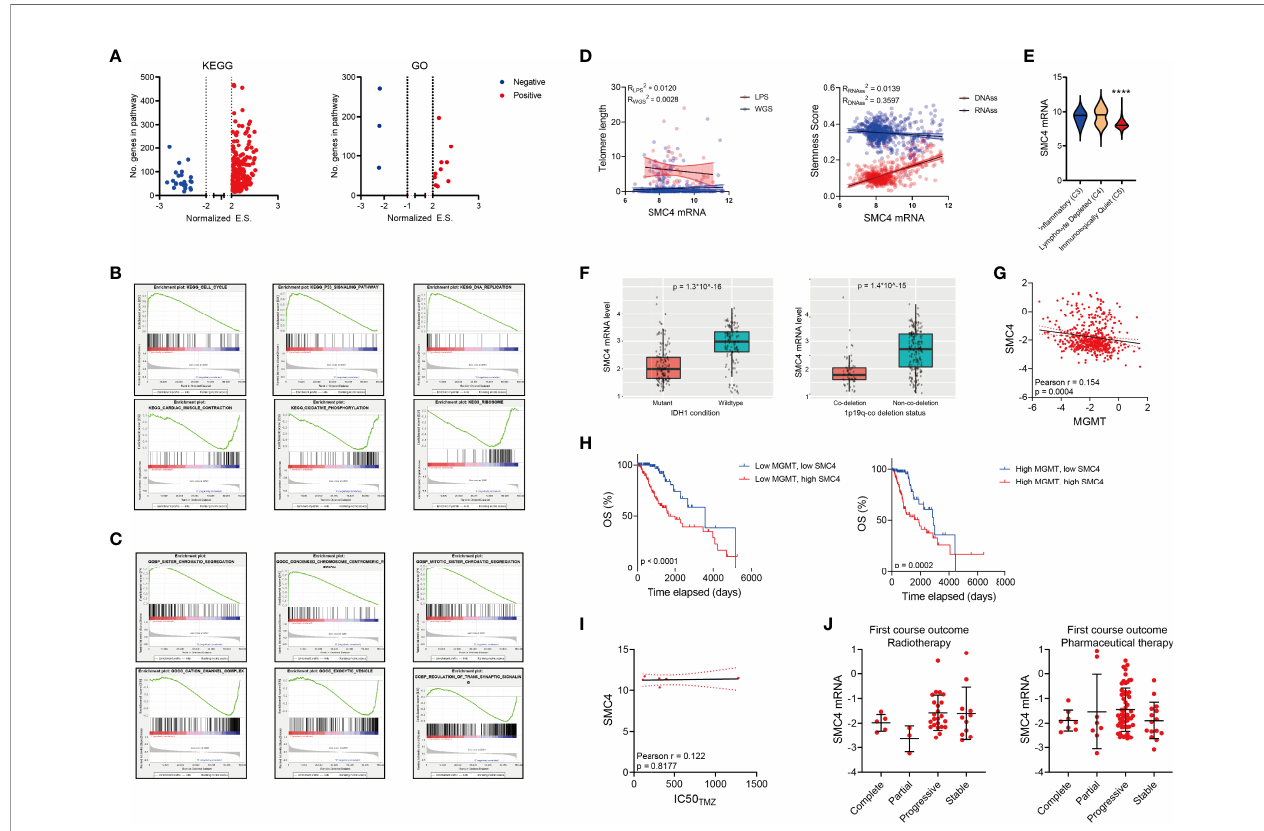
FIGURE 4 | SMC4 expression in patients with different molecular subtypes (A) Volcano plot showing the GSEA result comparing the enrichment score (E.S.) of different KEGG (the left panel) or GO (the right panel) pathways in glioma patients with high vs. low SMC4 levels. Up-regulated pathways are labeled in red and down-regulated pathways labeled in blue. (B, C) GSEA results showing the top 3 activated (the top panel) or suppressed pathways (the bottom panel) in KEGG (B) or GO (C) pathways. (D) Dot plot showing the correlation between SMC4 mRNA level and telomere length calculated with LPS or WGS methods (the left panel) or stemness score (the right panel) calculated based on mRNA or DNA level. The linear regression model with 95% CI were plotted. (E) Violin plot showing the expression of SMC4 mRNA in LGG patients with different immune subtypes. (F) Bar plot showing the expression of SMC4 mRNA in LGG patients with IDH mutation (the left panel) or 1p19q co-deletion (the right panel). (G) Dot plot showing the correlation between SMC4 mRNA and MGMT mRNA in LGG patients. Linear regression and 95% CI are shown in black. (H) Kaplan- Meier analysis comparing the survival of high vs. low SMC4 in low-MGMT expressing (the left panel) or high MGMT-expressing LGG patients (the right panel). (I) Dot plot showing the correlation between the IC50 of TMZ and SMC4 expression level in different LGG cell lines. Linear regression and 95% CI are shown in black. (J) Dot plot showing the expression level of SMC4 mRNA in LGG patients undergoing chemotherapy (the right panel) or radiotherapy (the left panel) with different outcomes. GO, Gene Ontology; LGG, lower-grade glioma. ****p <